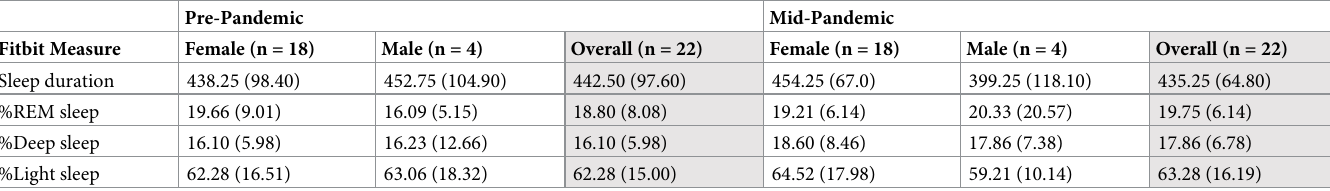
Table 3. Average values for sleep parameters measured by Fitbit on free days (median (IQR)).